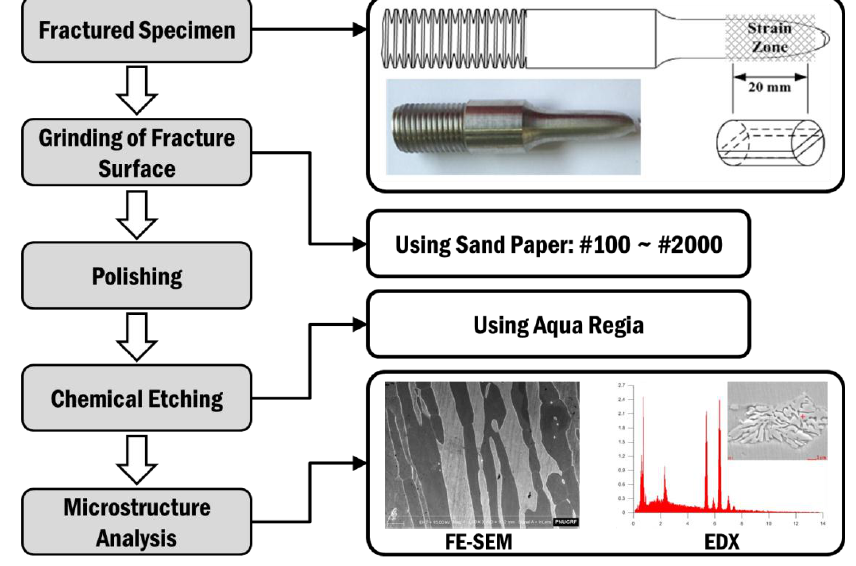
Figure 4. Procedure of microstructure analysis for tested SDSS